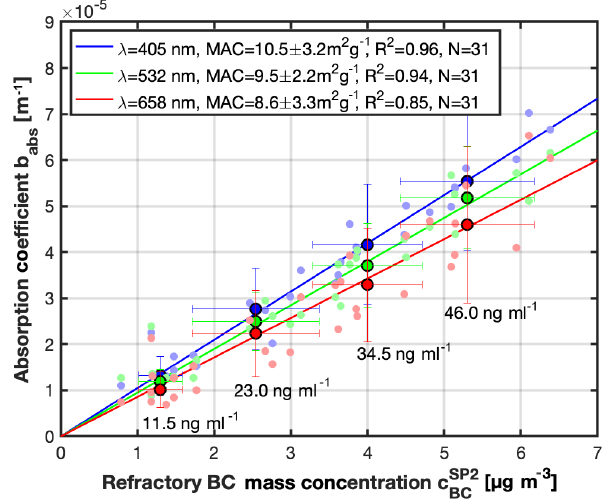
Figure 3. Determination of the mass-specific absorption cross sec- tion (MAC) of re-aerosolized fullerene soot suspension standards at 405, 532, and 658nm. The MAC values are given in the legend and are derived from concurrent measurements of the absorption coefficient, b abs , using the photoacoustic aerosol absorption spec- trometer PAAS-3 λ and the refractory BC mass concentration, c SP2 using the SP2. A linear regression without intercept was applied to the measurement data (solid